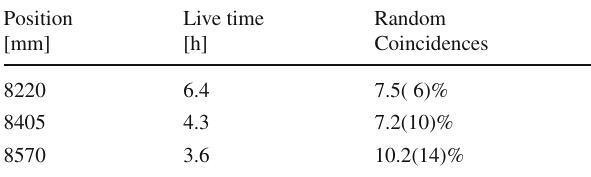
Table 1 Calibration data taken with a < 2kBq 228 Th source placed at different heights. The reported position corresponds to the absolute distance moved from the parking position on top of the experiment. The upper-most and lower-most HPGe detectors are situated at about 8180 and 8560 mm